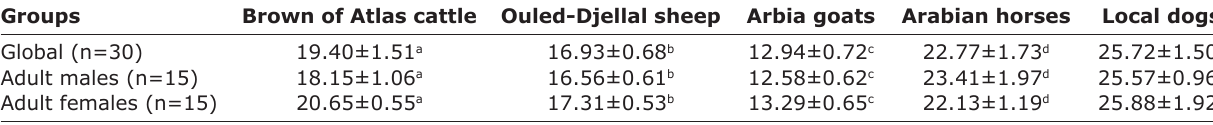
Table-2: Influence of red blood cells circumference on the species determination of pets (Group 1, expressed in μ m).